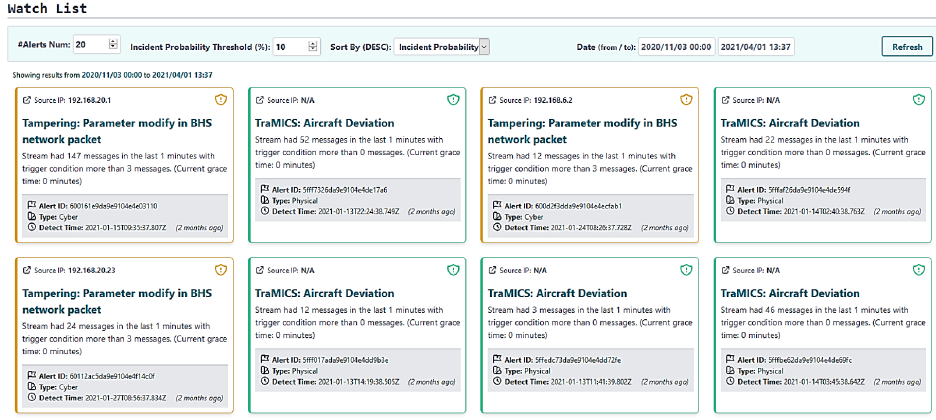
Figure 15. Watch List with example Alerts. Each card within the list has highlights of the Alert details (Figure 16). Users can click on any card to display the full details of the corresponding Alert (Figure 17). Furthermore, cards are displayed using indexed colours that reflect the severity level of each Alert (red for High, orange for Medium, and Green for low).